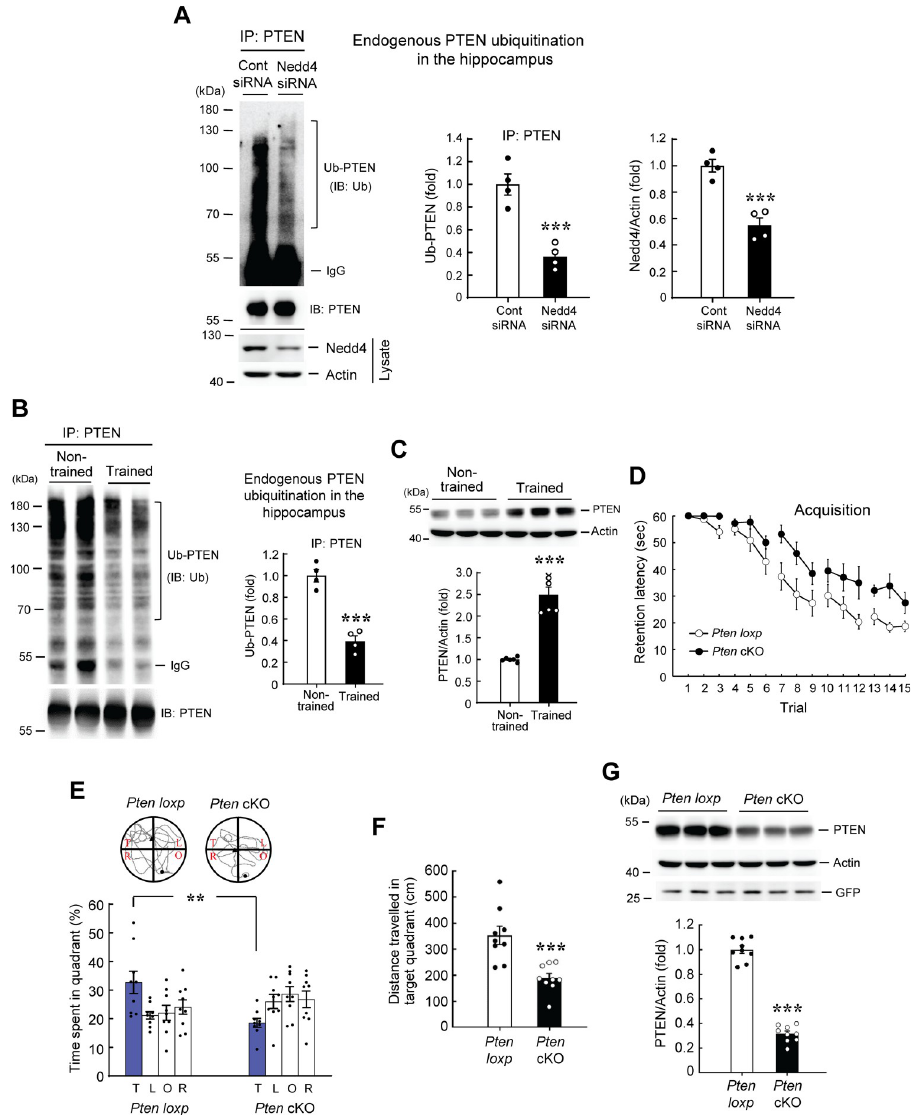
Fig 5. Spatial training decreases endogenous PTEN ubiquitination and Pten cKO mice show impaired spatial learning and memory. (A) Control siRNA or Nedd4 siRNA (10 pmol) was transfected to the rat CA1 area. The CA1 tissue lysates from these animals were immunoprecipitated with anti-PTEN antibody and immunoblotted with anti- ubiquitin and anti-PTEN antibodies. Endogenous PTEN ubiquitination level is decreased in Nedd4 siRNA-transfected rats (t 1,6 = 5.92, p = 0.001). The same cell lysates were also subjected to western blot determination of Nedd4 expression, and Nedd4 expression level is decreased in Nedd4 siRNA-transfected rats (t 1,6 = 6.22, p < 0.001). N = 4 each group. (B) The CA1 tissue lysates from non-trained and trained rats were immunoprecipitated with anti-PTEN antibody and immunoblotted with anti-ubiquitin and anti-PTEN antibodies. Endogenous PTEN ubiquitination level is decreased in trained rats (t 1,6 = 7.91, p < 0.001). N = 4 each group. (C) Rats were subjected to water maze training or swimming control (non-trained) and were sacrificed three days later. Their CA1 tissue was subjected to western blot determination of PTEN expression, and the PTEN expression level is increased in trained rats (t 1,10 = 8.59, p < 0.001). N = 6 each group. (D) The Pten loxp mice (that received lenti-GFP vector transduction) and Pten cKO mice (that received lenti-GFP-2A-NLS-Cre vector transduction) were subjected to water maze learning two weeks after lentivirus transduction. The Pten cKO mice showed impaired acquisition performance (N = 9 each group) (F 1,16 = 18.07, p < 0.001). (E) Probe trial performance (t 1,16 = 3.36, p < 0.01 for the target quadrant) and (F) Distance travelled in the target quadrant (t 1,16 = 4.23, p < 0.001) from the same animals as that in (D). The Pten cKO mice showed impaired retention performance and made less travelling in the target quadrant than the Pten loxp mice. (G) The PTEN expression level is decreased in the Pten cKO mice than the Pten loxp mice (t 1,16 = 17.96, p < 0.001). The GFP expression level is similar for these two groups of mice. Data are expressed as individual values and mean ± SEM. ** p < 0.01 and *** p ≦ 0.001. Ub: Ubiquitin.